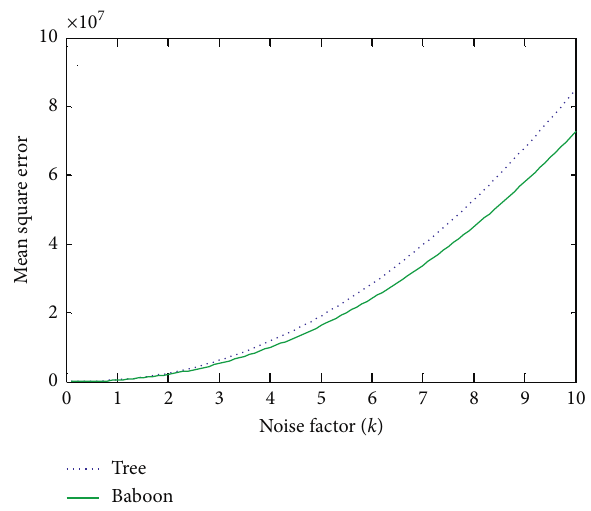
Figure 13: MSE plot of images tree and baboon with varying noise factor